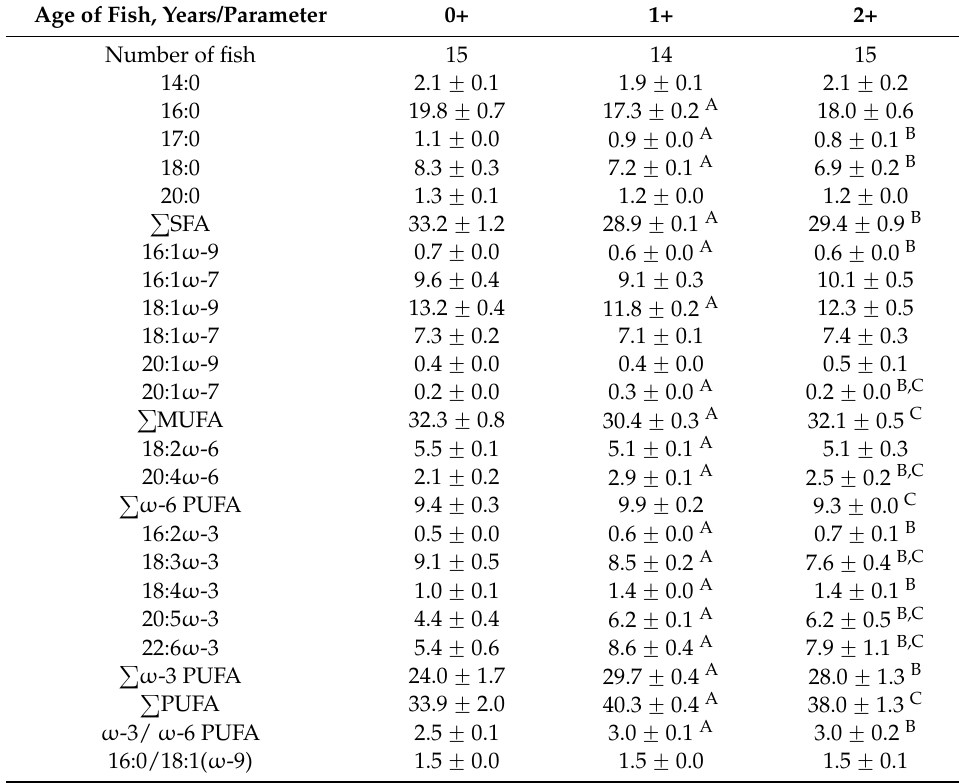
Table 2. Fatty acid spectrum (% total FAs) of juvenile Atlantic salmon at different ages (0+, 1+, and 2+ years) in the Sobachji shoal (the Varzuga River). Data are presented as average ˘